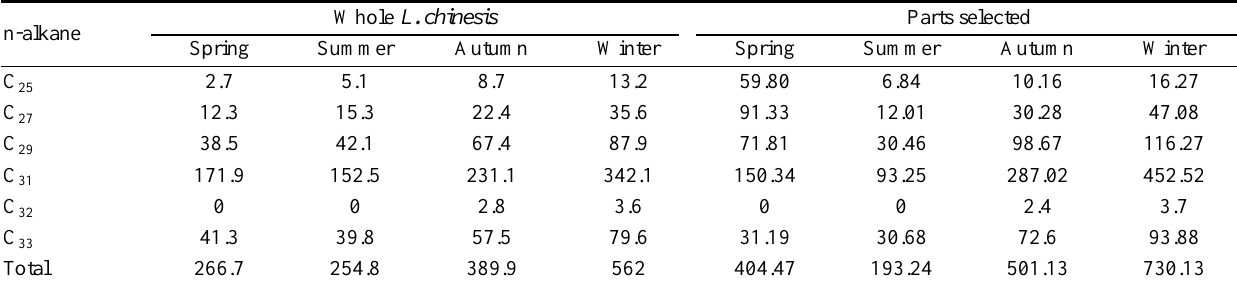
Table 3. The n-alkanes concentration patterns of whole L. chinesis or parts selected by goats (mg/kg) Whole L. chinesis Parts selected n-alkane Spring Summer Autumn Winter Spring Summer Autumn